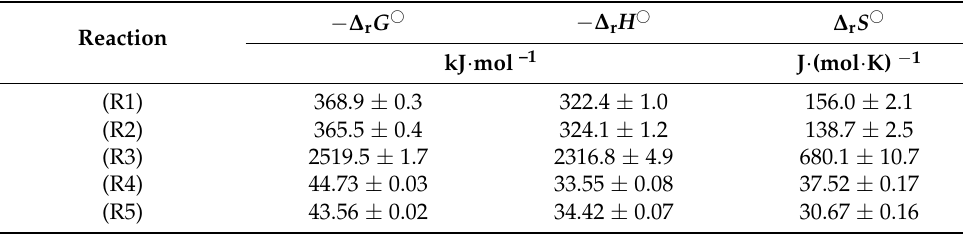
Table 3. The values of standard thermodynamic functions of the reactions